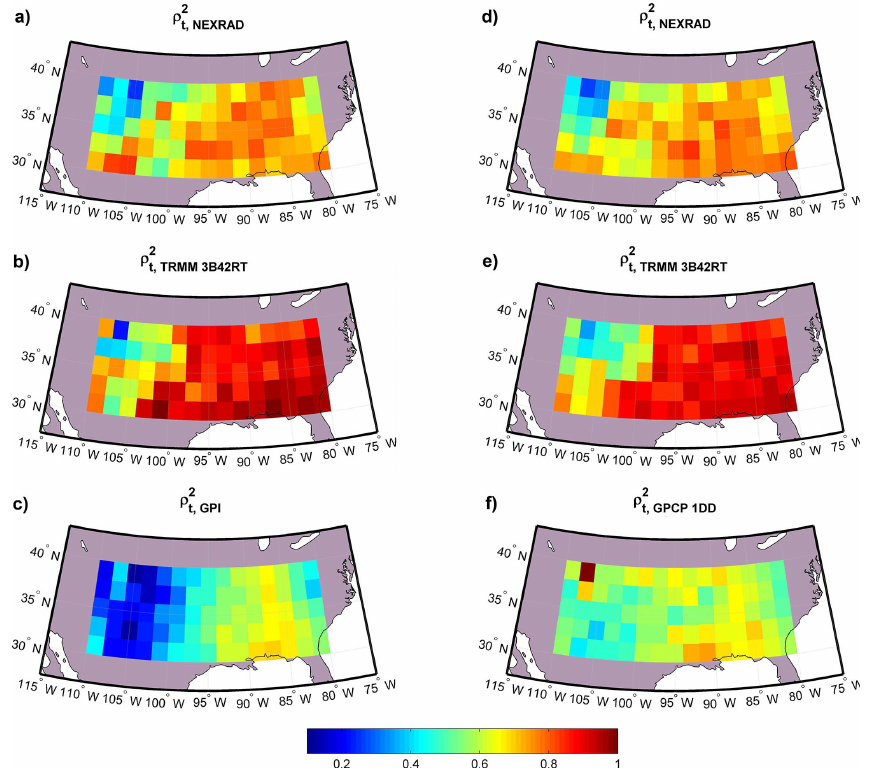
Figure 7. Correlation coefficient between the truth and each precipitation product. The left column shows the results for triplets in group 1, and the right column shows the results for triplets in group